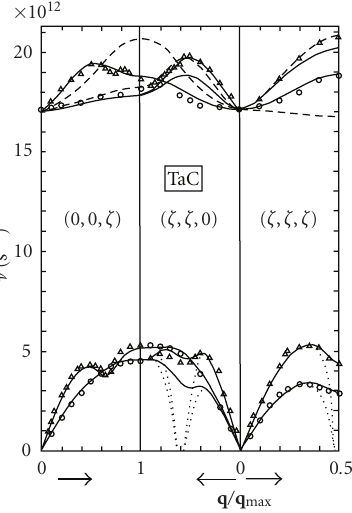
Figure 2: Phonon dispersions of TaC (data points) [4] and calculations based on the double-shell model of W. Weber [5].